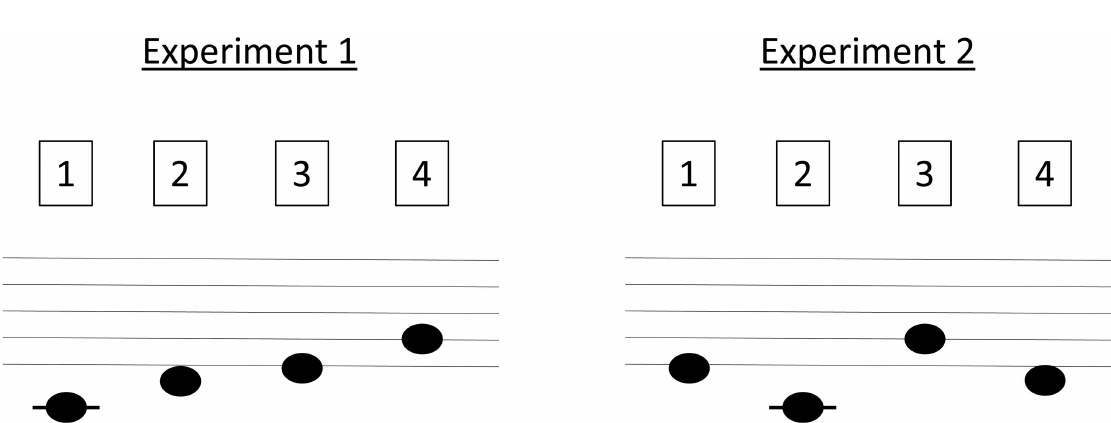
Fig 2. The auditory-motor mapping of Experiment 1 and Experiment 2. In Experiment 1 tones were ordered from low to high and corresponded to the spatial position from left to right on the computer keyboard (C = key 1, D = key 2, E = key 3, G = key 4). In Experiment 2 the order of notes was scrambled (E = key 1, C = key 2, G = key 3, D = key 4).